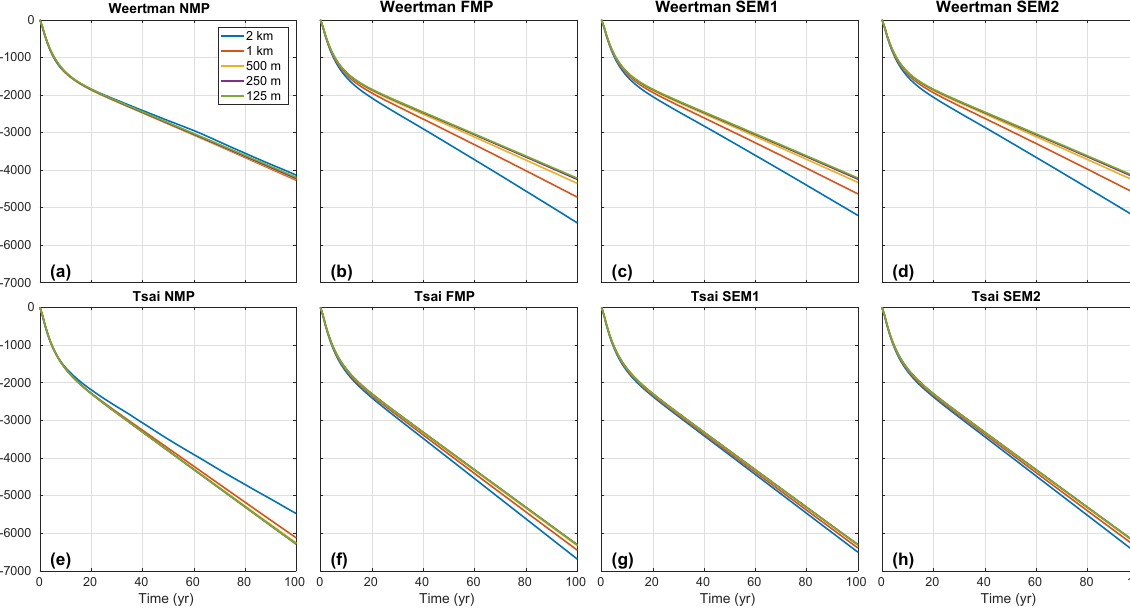
Figure 5. Evolution of ice volume above floatation in experiment 1 for the NMP (a, e) , FMP (b, f) , SEM1 (c, g) , and SEM2 (d, h) for the Weertman (a–d) and Tsai (f–h) friction laws. Each plot represents the evolution for the five mesh resolutions: 2km (blue), 1km (red), 500m (yellow), 250m (purple), and 125m